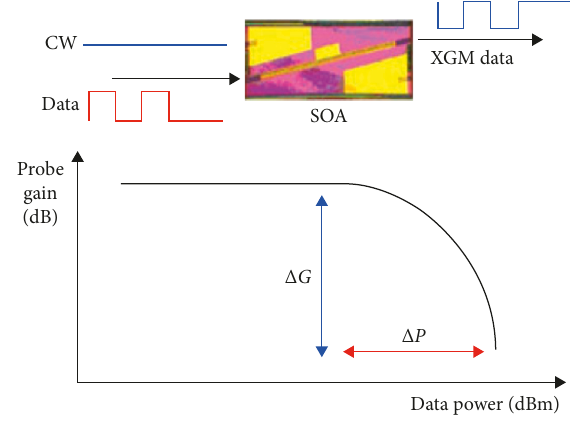
Figure 2: Optical wavelength conversion cross gain modulation (XGM) operation principle